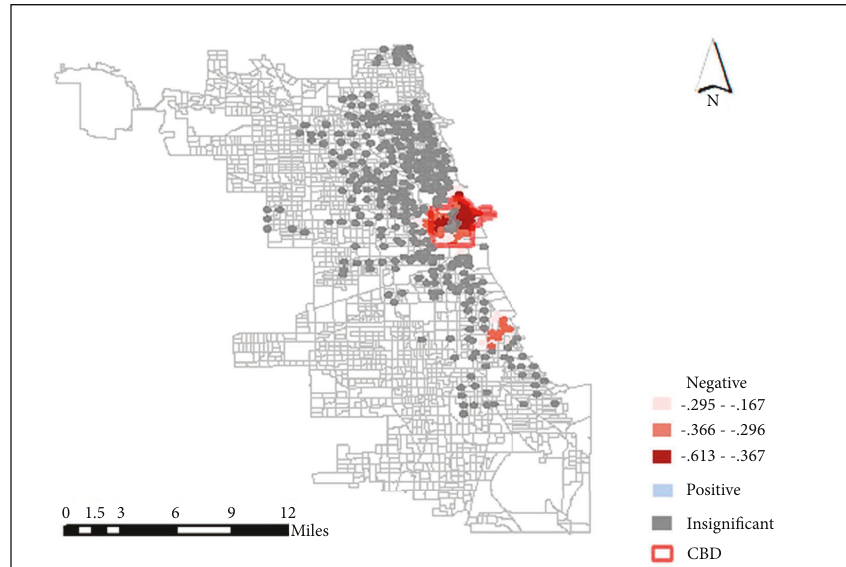
Figure 10: Distribution of office employment density regression